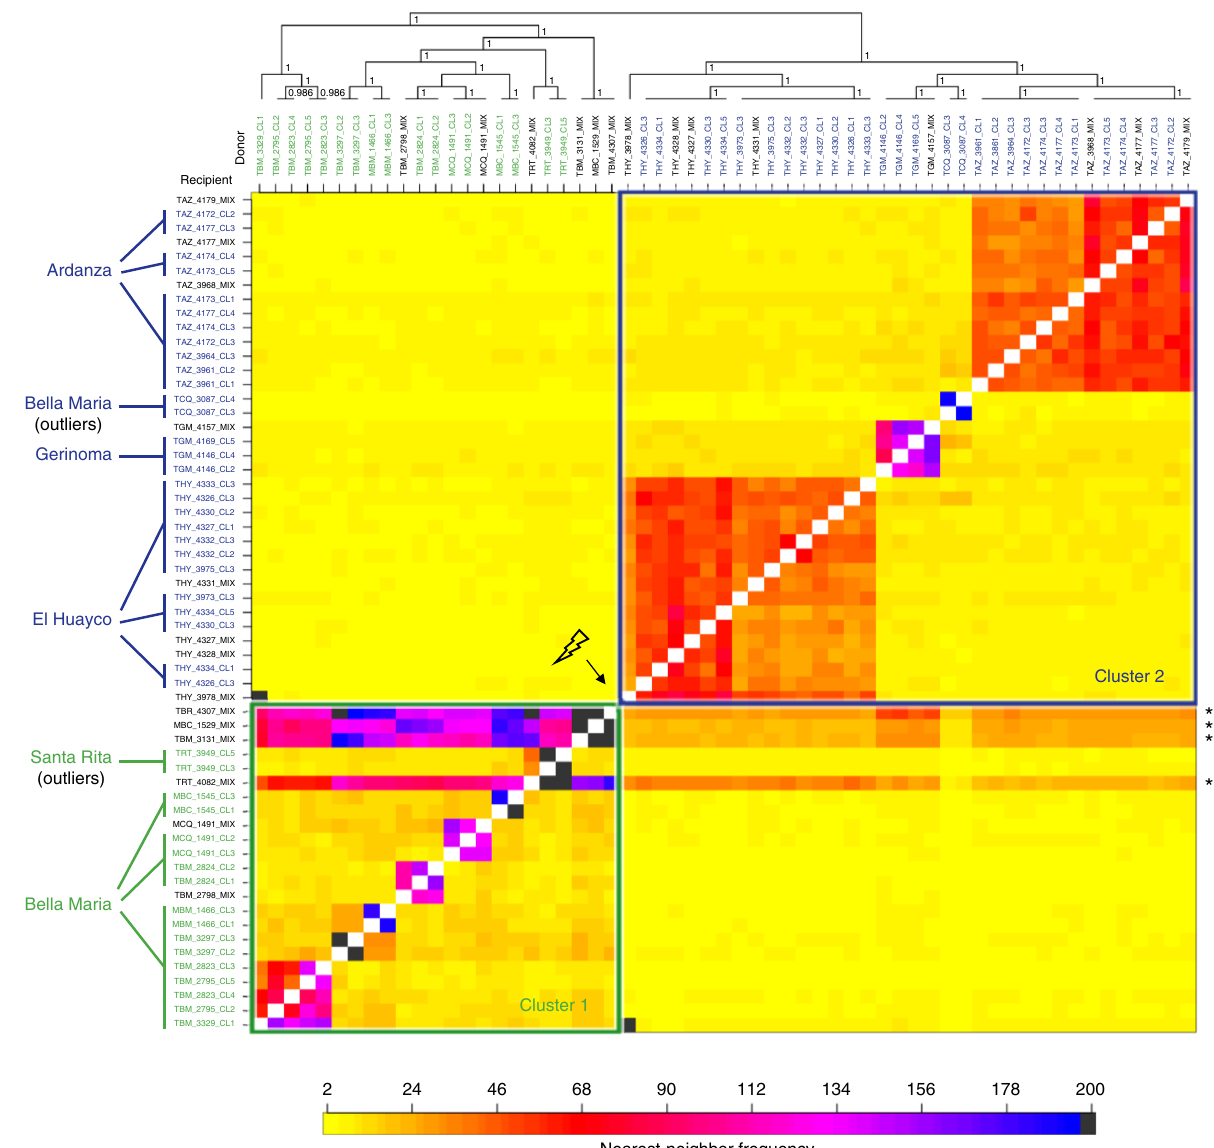
Fig. 2 Haplotype co-ancestry among T. cruzi I clones from southern Ecuador. The heatmap of co-ancestry is based on a sorted haplotype co-ancestry matrix x ij , which estimates the number of discrete segments of genome i that are most closely related to the corresponding segment of genome j . These nearest- neighbor relationships from fi neSTRUCTURE 28 analysis are sorted such that samples clustered along the diagonal are those that most share recent genealogical events, and pairwise comparisons outside of the diagonal indicate levels of genetic connectivity among these clusters. The matrix also includes ‘ genomes ’ of non-cloned T. cruzi cultures. Strong horizontal banding points to the accumulation of diversity from throughout the dataset in four of these original infections. Cell color represents the frequency of nearest-neighbor relationships for each sample pair, increasing from yellow (2) through red (68) and pink (134) to black (200). Four anomalous (outlier) samples are described further on in main text. Analysis uses 110,326 phased SNP sites